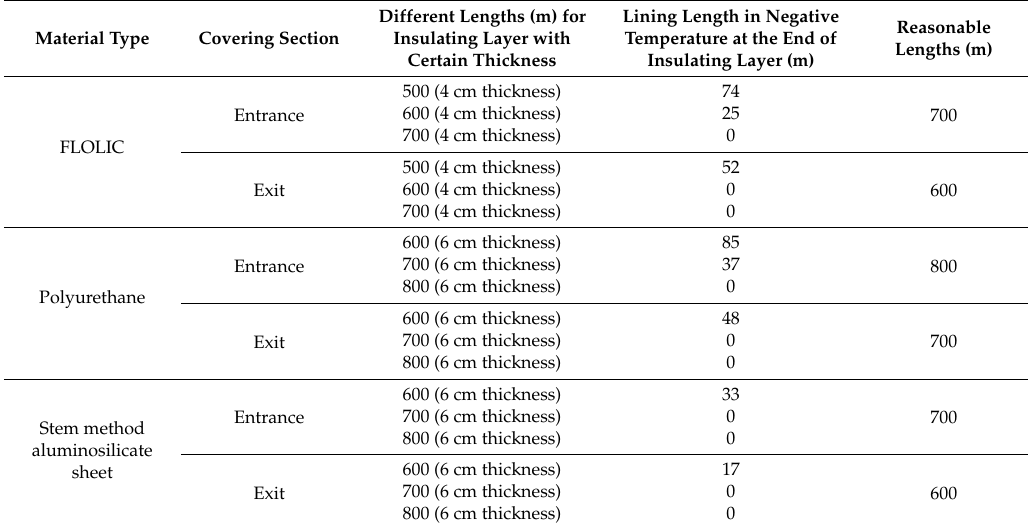
Table 4. Optimization of design length for different heat-insulating